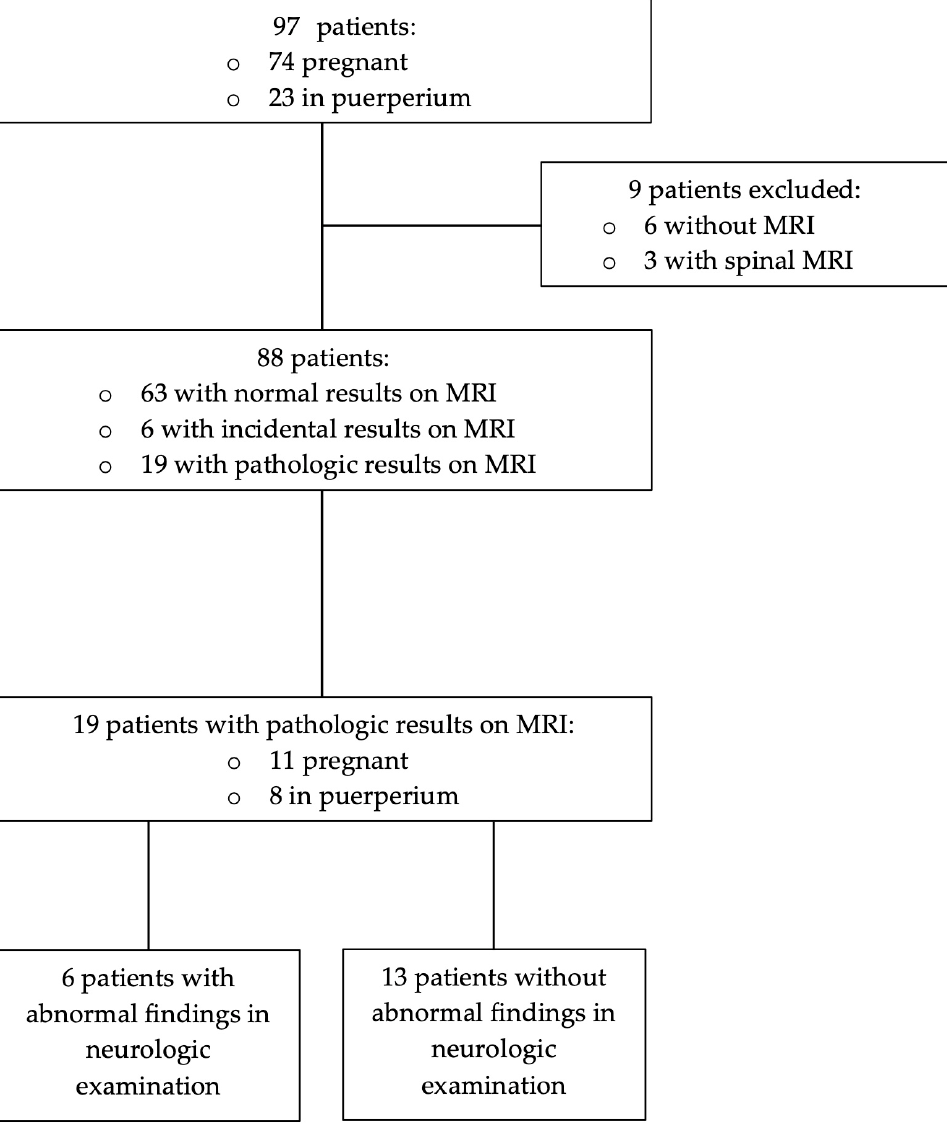
Figure 1. Study population. A total population of 97 patients from the emergency department of the clinic for Gynaecology, Obstetrics and Reproductive Medicine of Saarland University, Homburg,